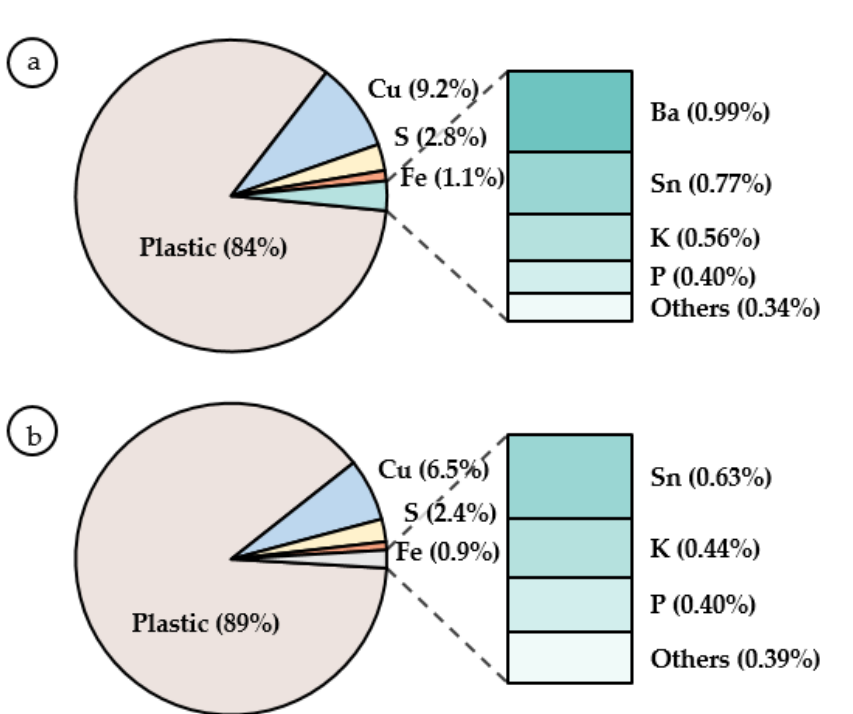
Figure 8. Elemental composition (wt%) of the treated circuit board after leaching with Fe 3+ in ( a ) biotic and ( b ) abiotic medium.